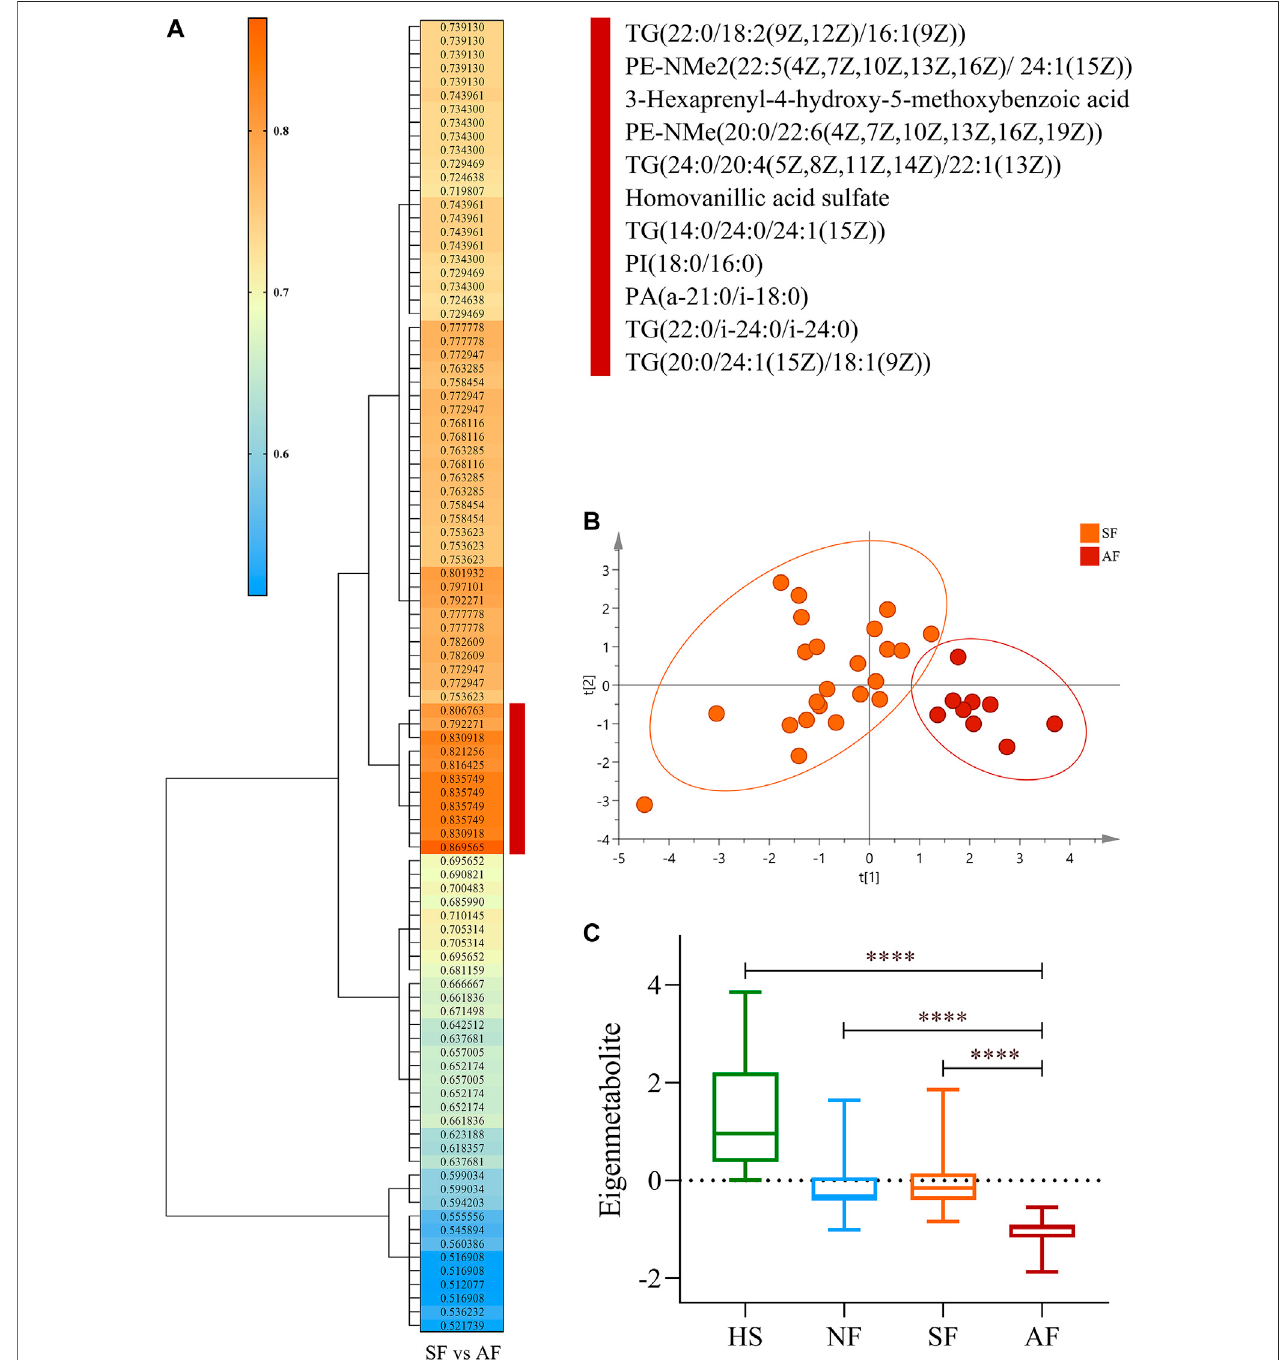
FIGURE 3 | Identi fi cation of the metabolite fi ngerprint related to fi brosis progression. (A) Hierarchical cluster analysis of the area under the receiver operating characteristic curve and p -value differentiation between SF and AF groups. Vertical brownish-red bar identi fi ed the 11-metabolite cluster, which acted as the advanced fi brosis – associatedmetabolite fi ngerprint. (B) Principalcomponentanalysisoftheadvanced fi brosismetabolite fi ngerprintbetweentheSFandAFgroups. (C) Changeof the advanced fi brosis eigenmetabolite in DILI patients with different stages of fi brosis progression. Data are presented as mean ± SD. **** p < 0.0001, compared with the AF group. HS, healthy subjects; NF, nonsigni fi cant fi brosis; SF, signi fi cant fi brosis; AF, advanced fi brosis.